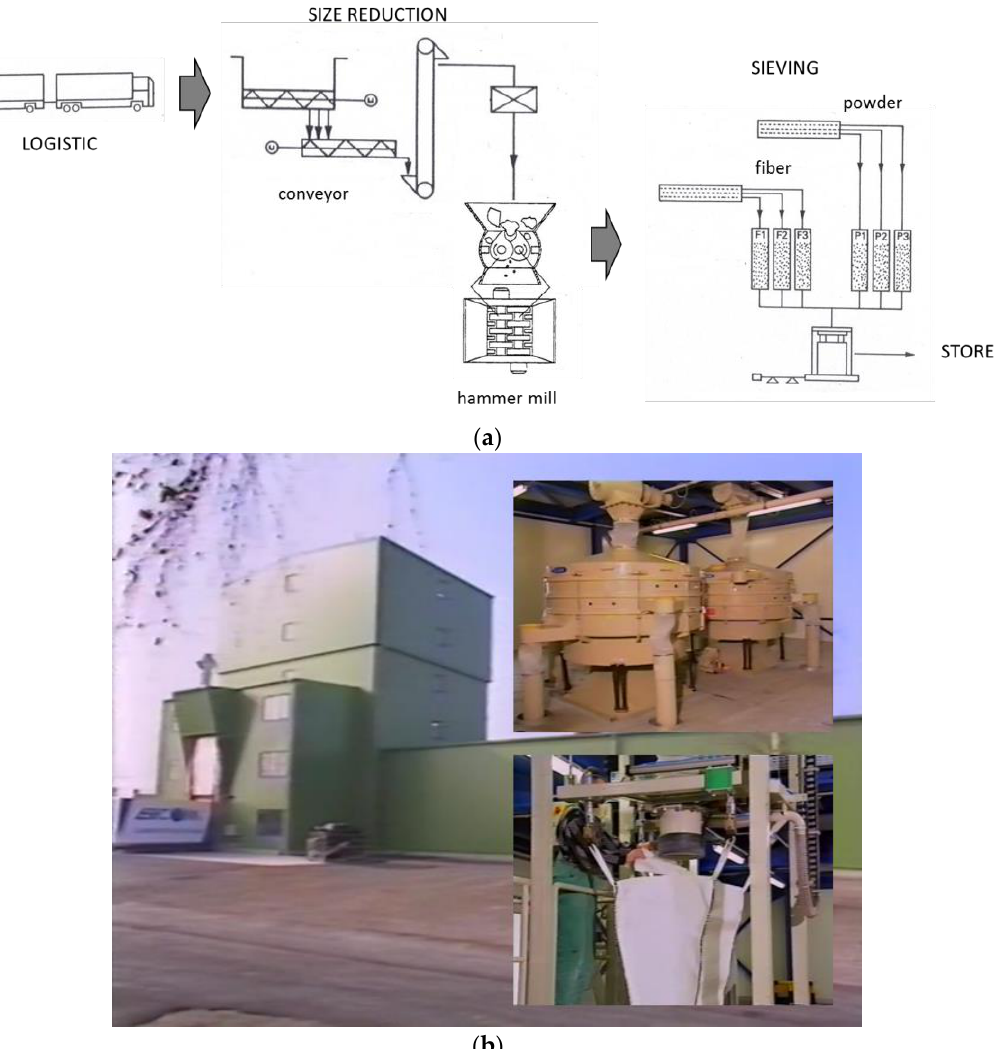
Figure 3. ERCOM installation for SMC/BMC (Bulk Molding Compound) recyclates: ( a ) scheme; ( b ) general view as well as sieving and packing hubs.